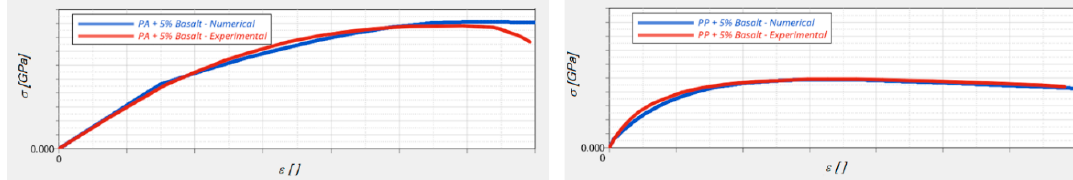
Figure 3. Constitutive law (stress vs. strain) for PA + 5%B and PP + 5%B.